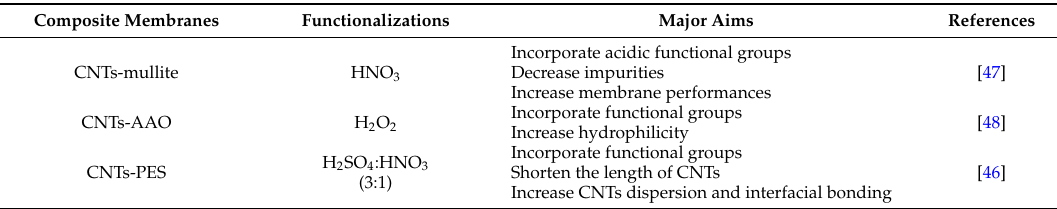
Figure 6. TEM and SEM images of raw CNTs (1) and functionalized CNTs (2) after different functionalization methods: ( a ) non-covalent modification [45] and ( b ) covalent modification [46]. Table 2. Functionalization of CNTs.